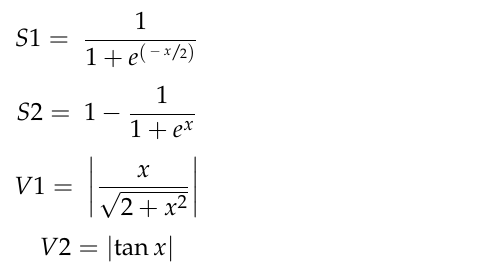
Figure 2. Identification of selected features as obtainable in every instance of the entire dataset.